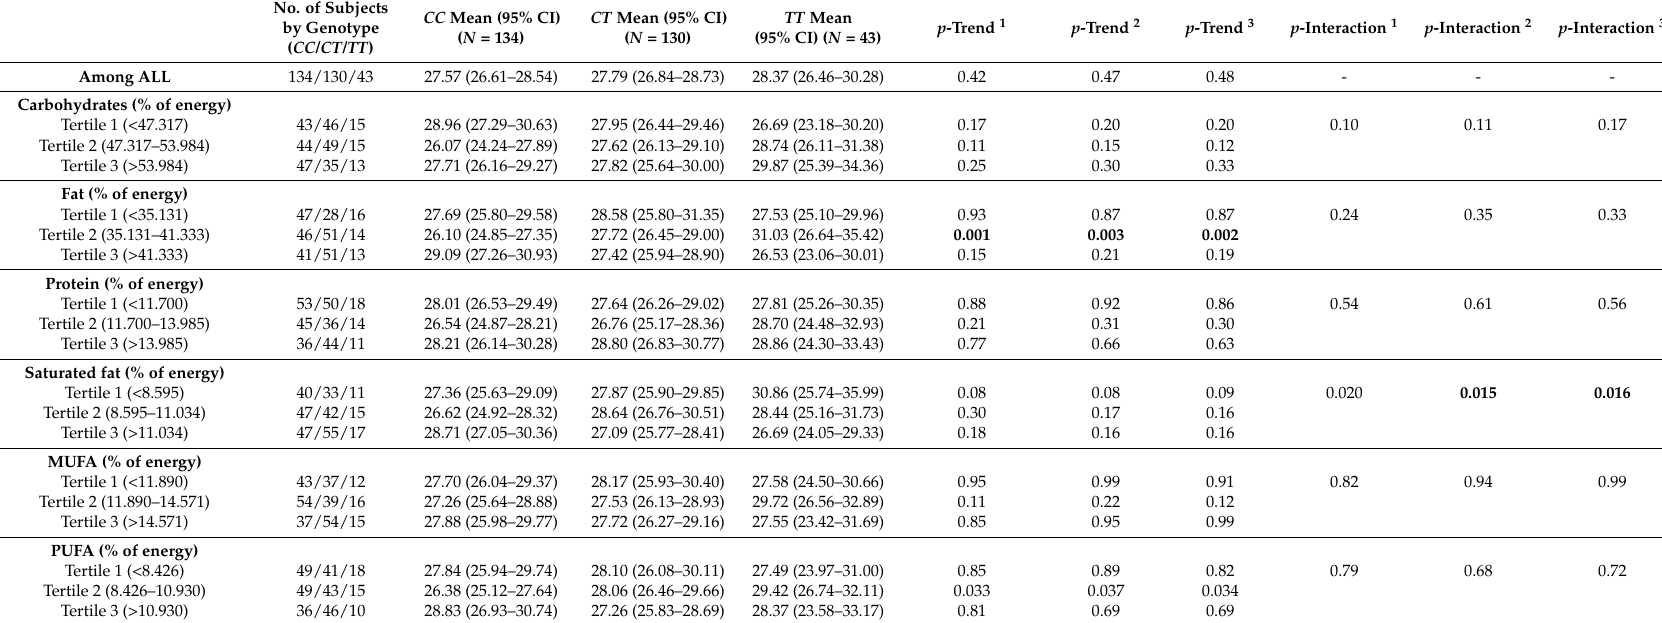
Table 3. Interaction between daily dietary intake and TCF7L2 ( rs7903146 ) genotypes with BMI (kg/m 2